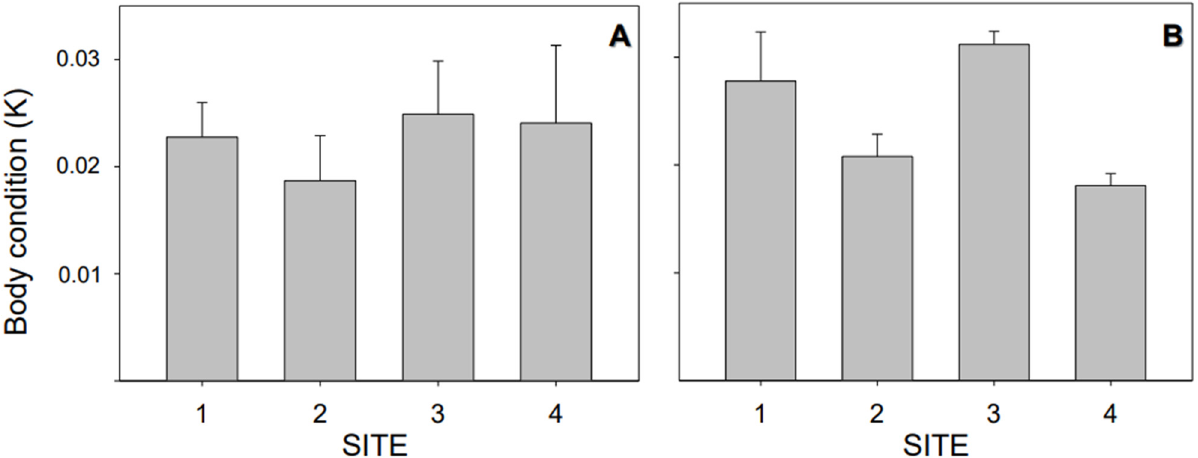
Figure 2. Individual endpoint measured in Jenynsia multidentata collected at the four study sites (S1 to S4), with body condition based on residual analysis in the dry ( A ) and wet ( B ) seasons. The whiskers represent the ± SEM.